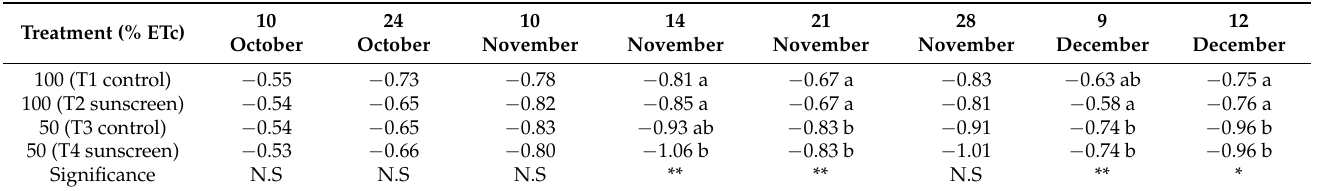
Table 4. Stem water potential (MPa) measured in the performed treatments on the ‘Star’ along the season.